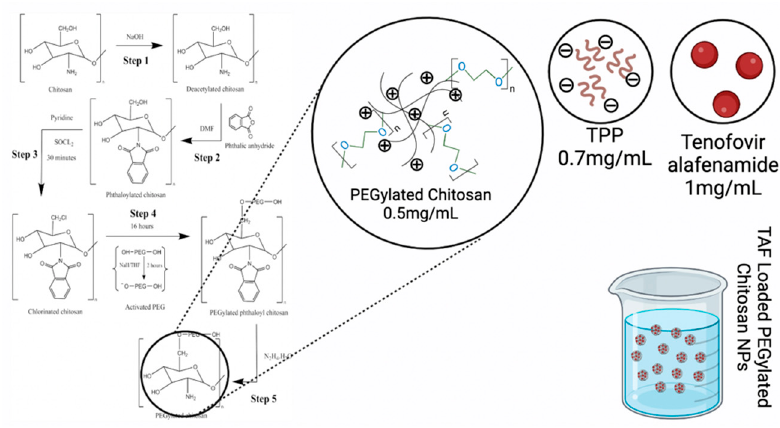
Figure 2. Graphical representation of the preparation of TAF nanoparticles.